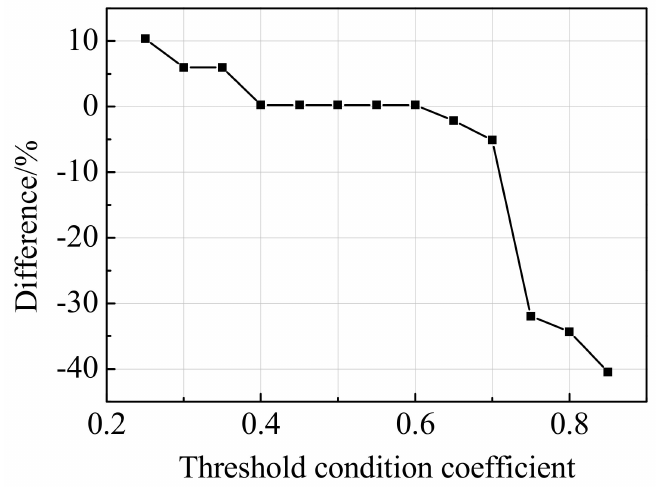
Figure 13. The di ff erence of results of train speed estimation with di ff erent threshold condition coe ffi